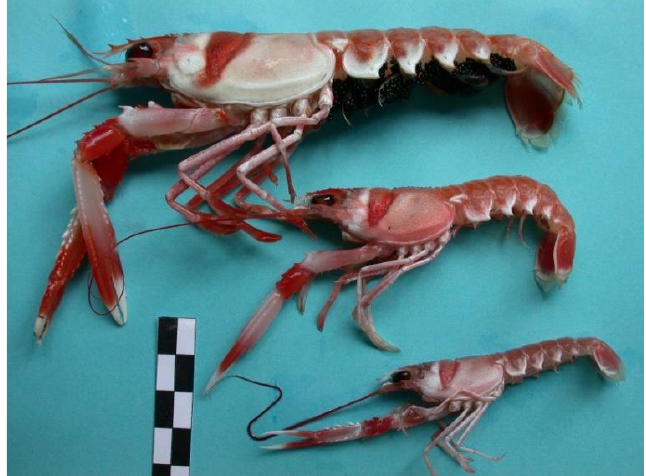
Figure 1. Some individuals of Nephrops norvegicus.